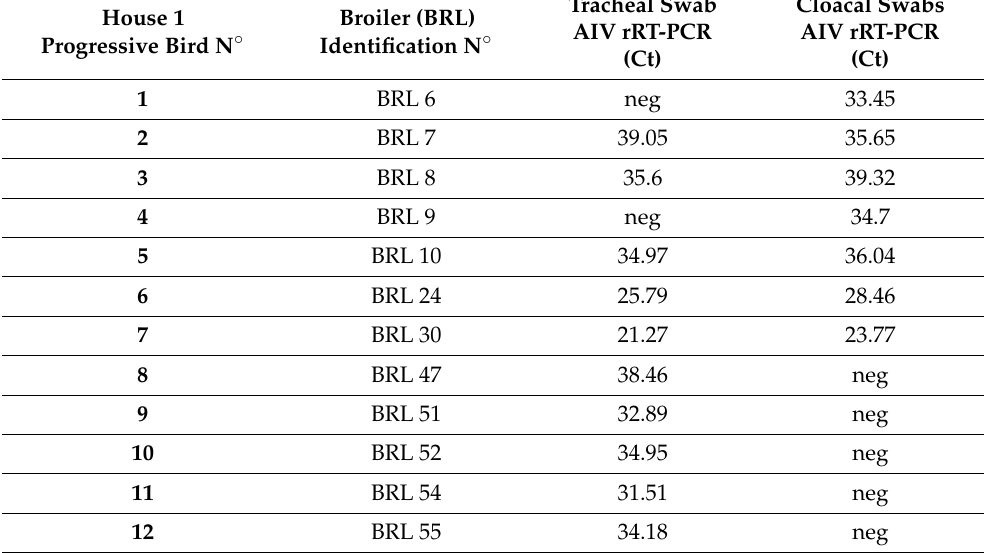
Table 1. Results of rRT-PCR for AIV of samples collected in 12 positive live birds out of 60 (20%) in house